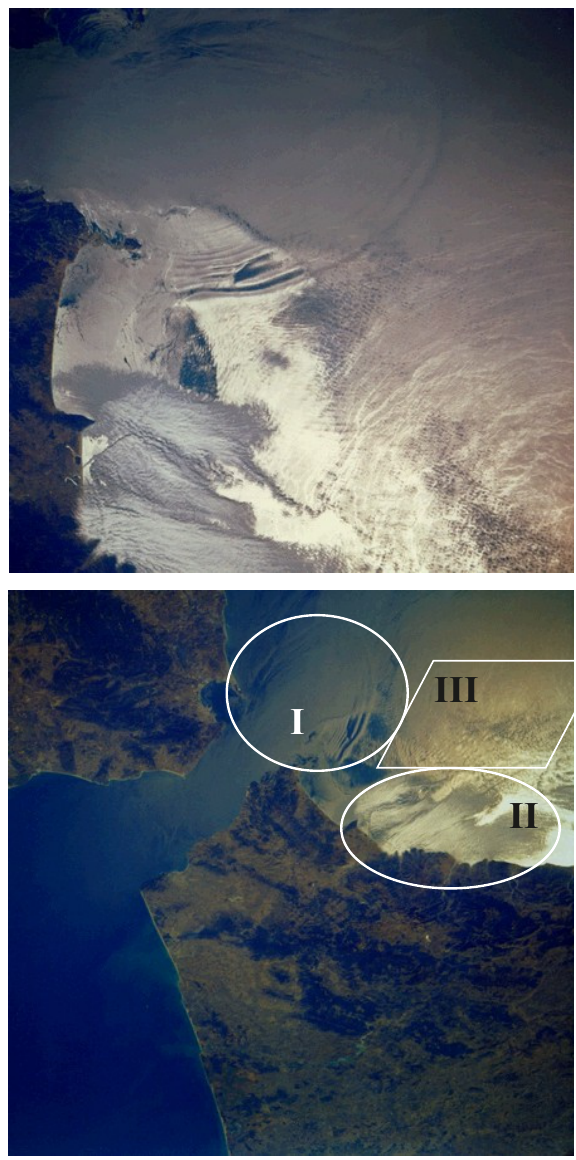
Fig. 7. Surface manifestation of hydrodynamic phenomena: initial internal waves (I), periodic shear flows (II) and internal waves of the previous tidal period (III) in the Alboran Sea (36 ◦ N, 5 . 5 ◦ W; 12 October 1984): NASA photos STS41G-34-98 (12:04:06UTC) (rotated left) and STS41G-40-51(12:04:09UTC). Colour balance and brightness were modified to achieve appropriate view of